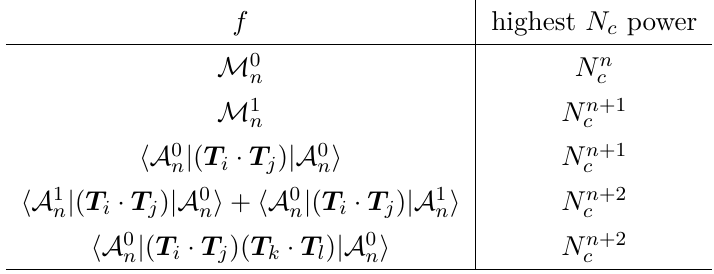
Table 1 . Highest power of N c appearing in the squared